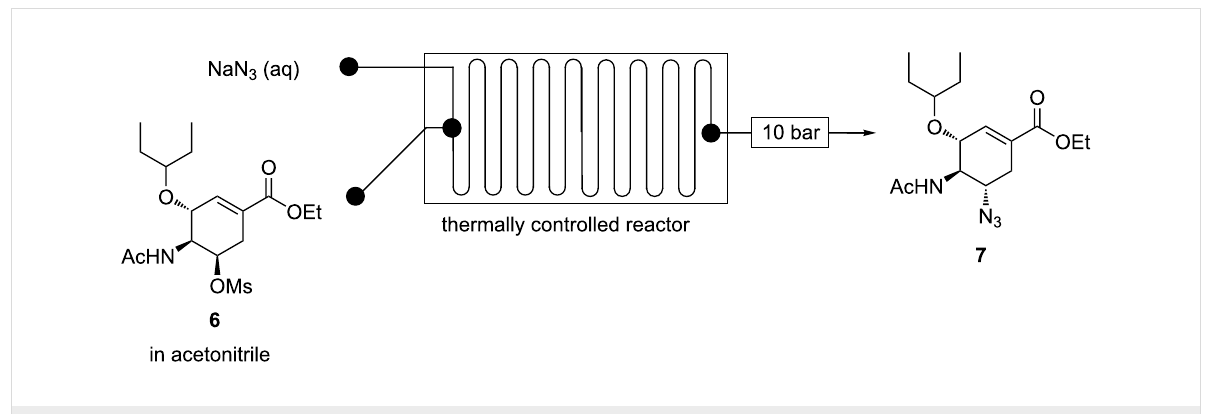
Figure 15: Continuous flow system for C-5 azidation of acetamide 6 using NaN 3 .